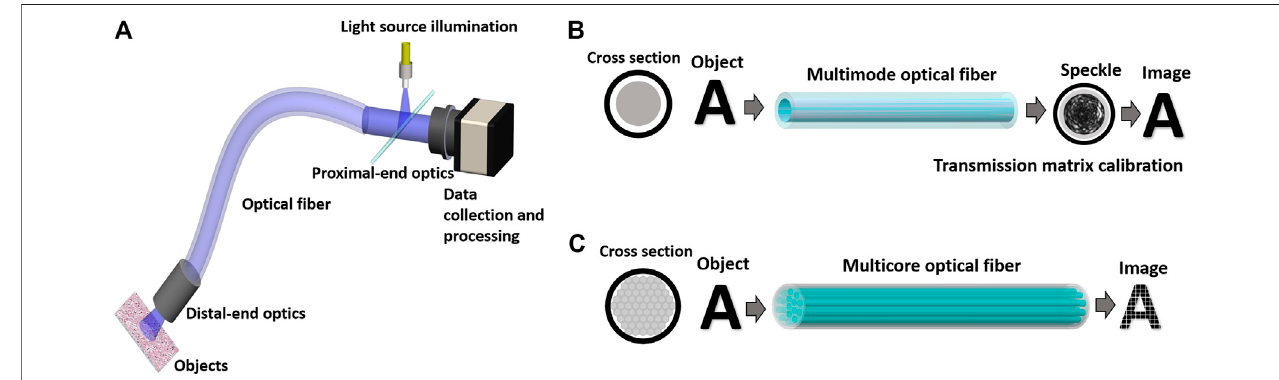
Frontiers in Physics |